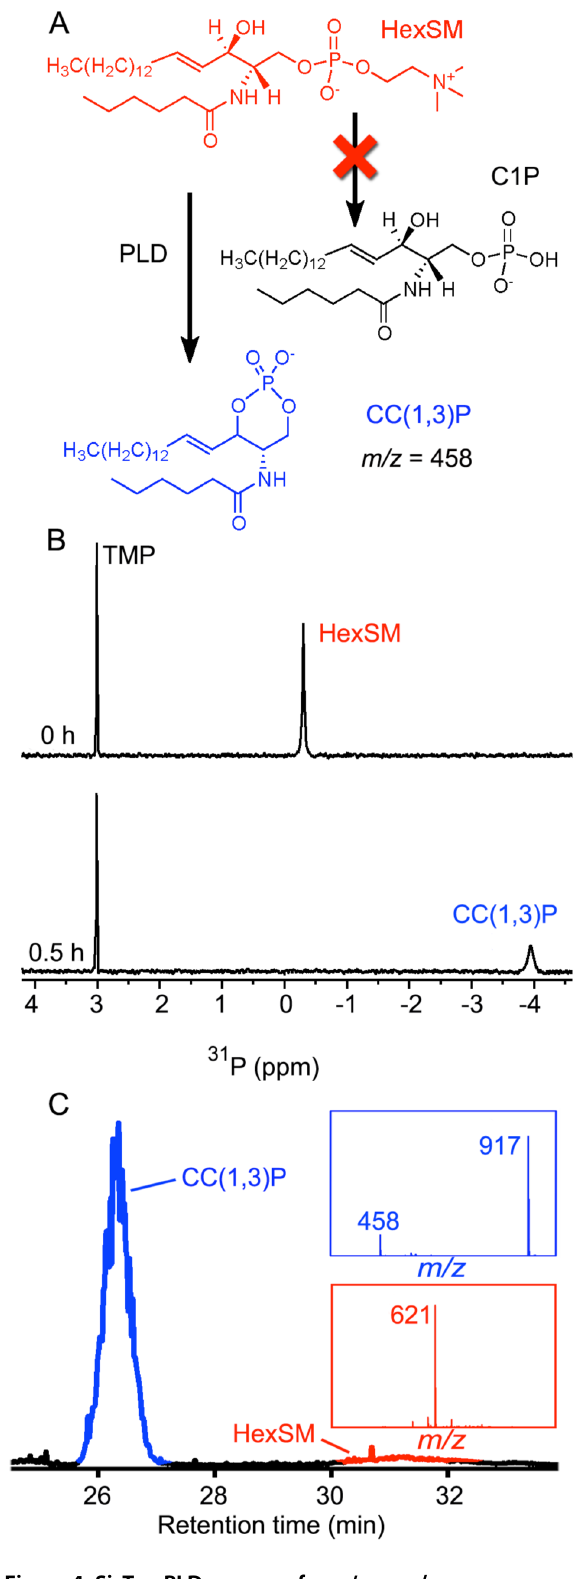
Figure 4. SicTox PLD enzymes from Loxosceles venoms convert sphingomyelin to cyclic ceramide phosphates. (A) Sphingomyelin (SM) is not converted not to ceramide-1-phosphate (C1P) but to a cyclic six membered ceramide(1,3)phosphate [CC(1,3)P]. (B) 31 P-NMR spectra of 4 mM hexanoyl SM (HexSM) micelles, before (top) and 30 min